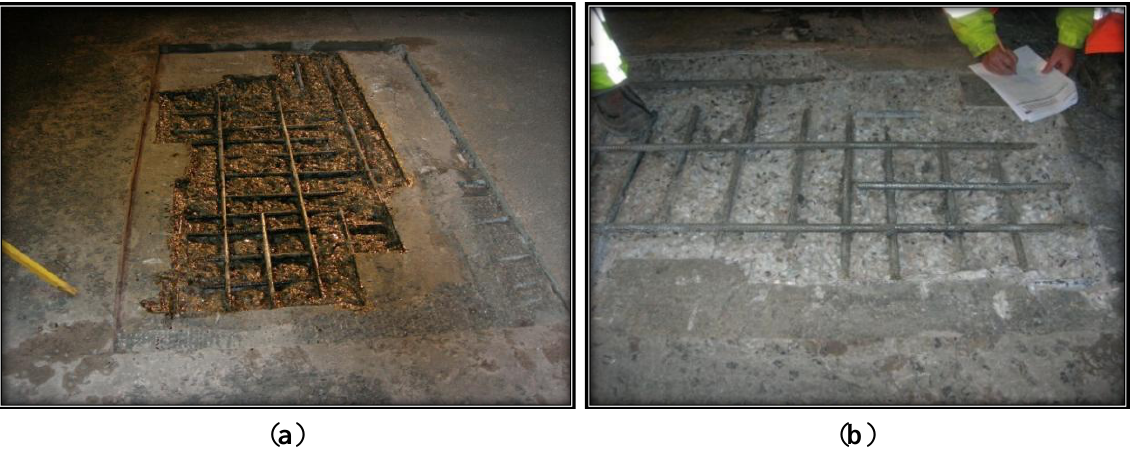
Figure 13. ( a ) Area of moisture damage ( b ) replaced with new rebars